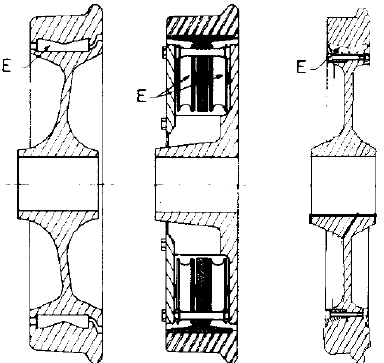
Figure 2. Various resilient wheels. E stands for the location of the elastomeric damping material [8].